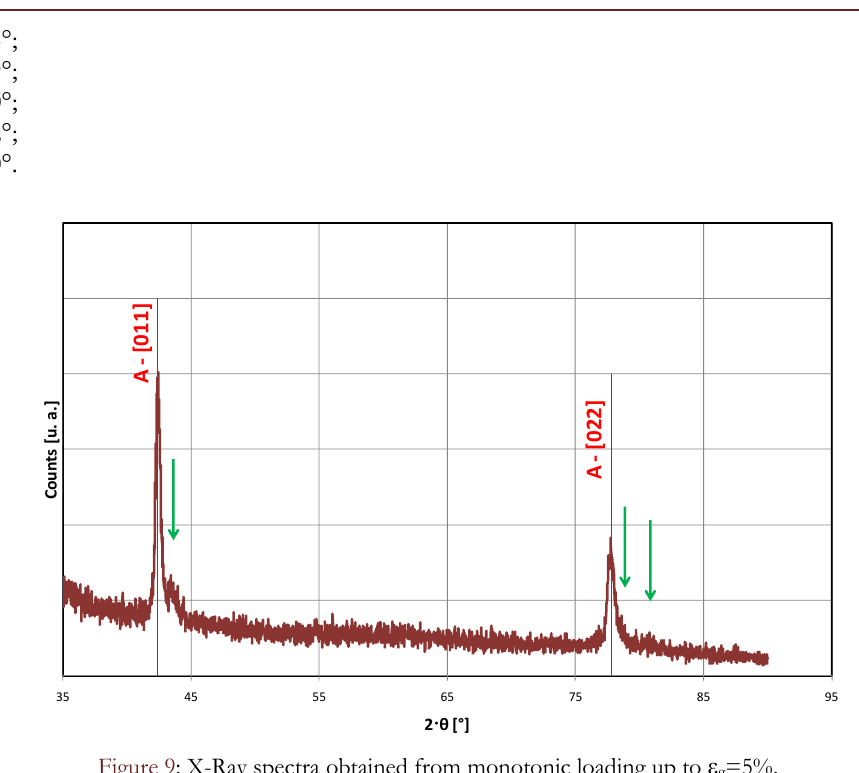
Figure 9: X-Ray spectra obtained from monotonic loading up to  g =5%.